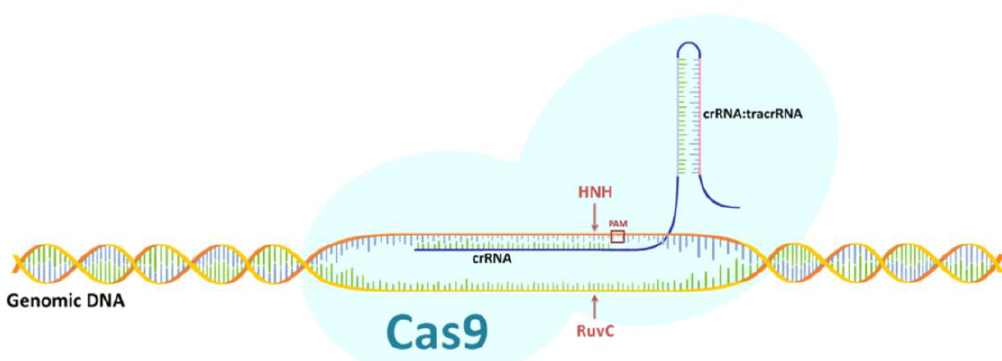
Figure 1. Diagram of CRISPR/Cas9 system. Description of a figure in the text.